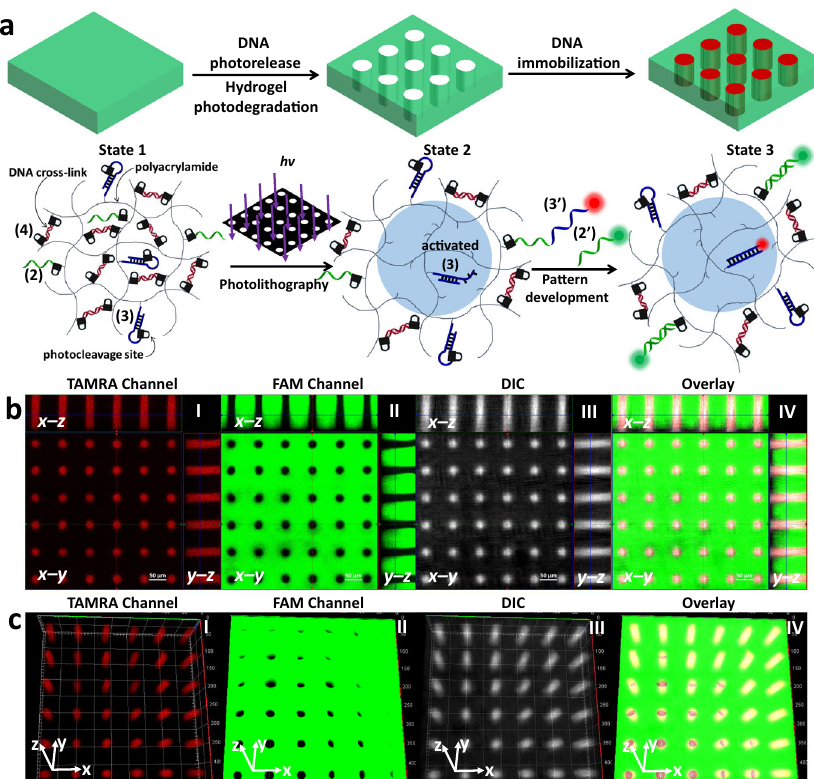
Fig. 5 Photolithographic patterning of periodically-separated non-crosslinked polymer circular domains within a continuous crosslinked hydrogel. a The patterned domains are functionalized with the activated (3) duplex in a continuous hydrogel fi lm modi fi ed with the o-nitrobenzylphosphate ester modi fi ed units that include (2), (3) and the photocleavable crosslinker (4). The resulting photopatterned hydrogel fi lm dictates the selective hybridization of TAMRA-modi fi ed (3 ’ ) with the activated (3) units associated with the hole domains, and the hybridization of the FAM-functionalized (2 ’ ) with the tethers (2) associated with the continuous hydrogel matrix. b Three-dimensional confocal microscope images of the photopatterned hydrogel fi lm. Panel I — Confocal fl uorescence microcopy image of the hydrogel fi lm using the TAMRA channel. Panel II — Confocal fl uorescence microscope image using the FAM channel. Panel III — Differential interference contrast (DIC) mode image. Panel IV — Overlay image of the patterned hydrogel fi lm. Scale bars correspond to 50 μ m. c Reconstructed three-dimensional confocal microscope images of the photopatterned hydrogel fi lm. Panel I — The reconstructed TAMRA patterned hole domains. Panel II — The reconstructed image of the continuous FAM labeled hydrogel matrix. Panel III — The reconstructed image of patterned hole domains using differential interference contrast (DIC) mode image. Panel IV — The reconstructed overlay image of the patterned hydrogel fi lm. N = 4 independent experiments were